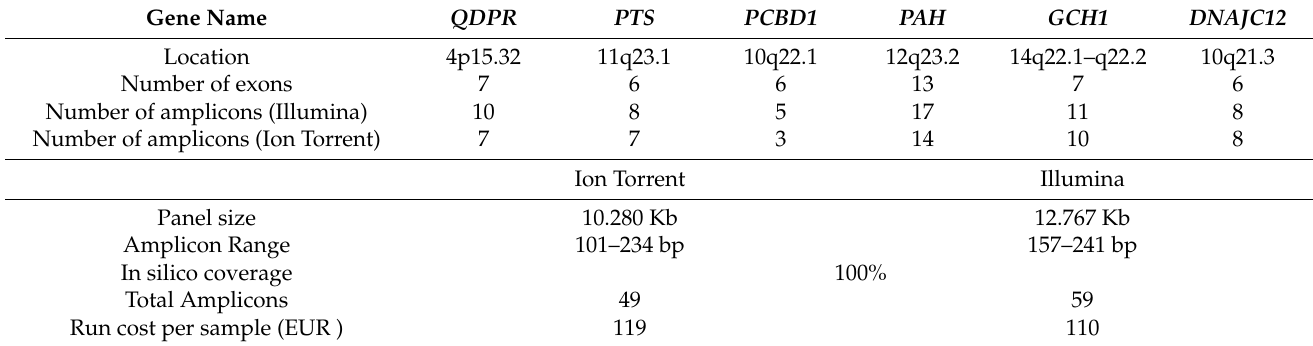
Table 3. NGS-targeted custom panels designed with AmpliSeqTM Designer Tool for Ion Torrent platform, and DesignStudio Sequencing Assay Designer for Illumina platform to analyze HPA related